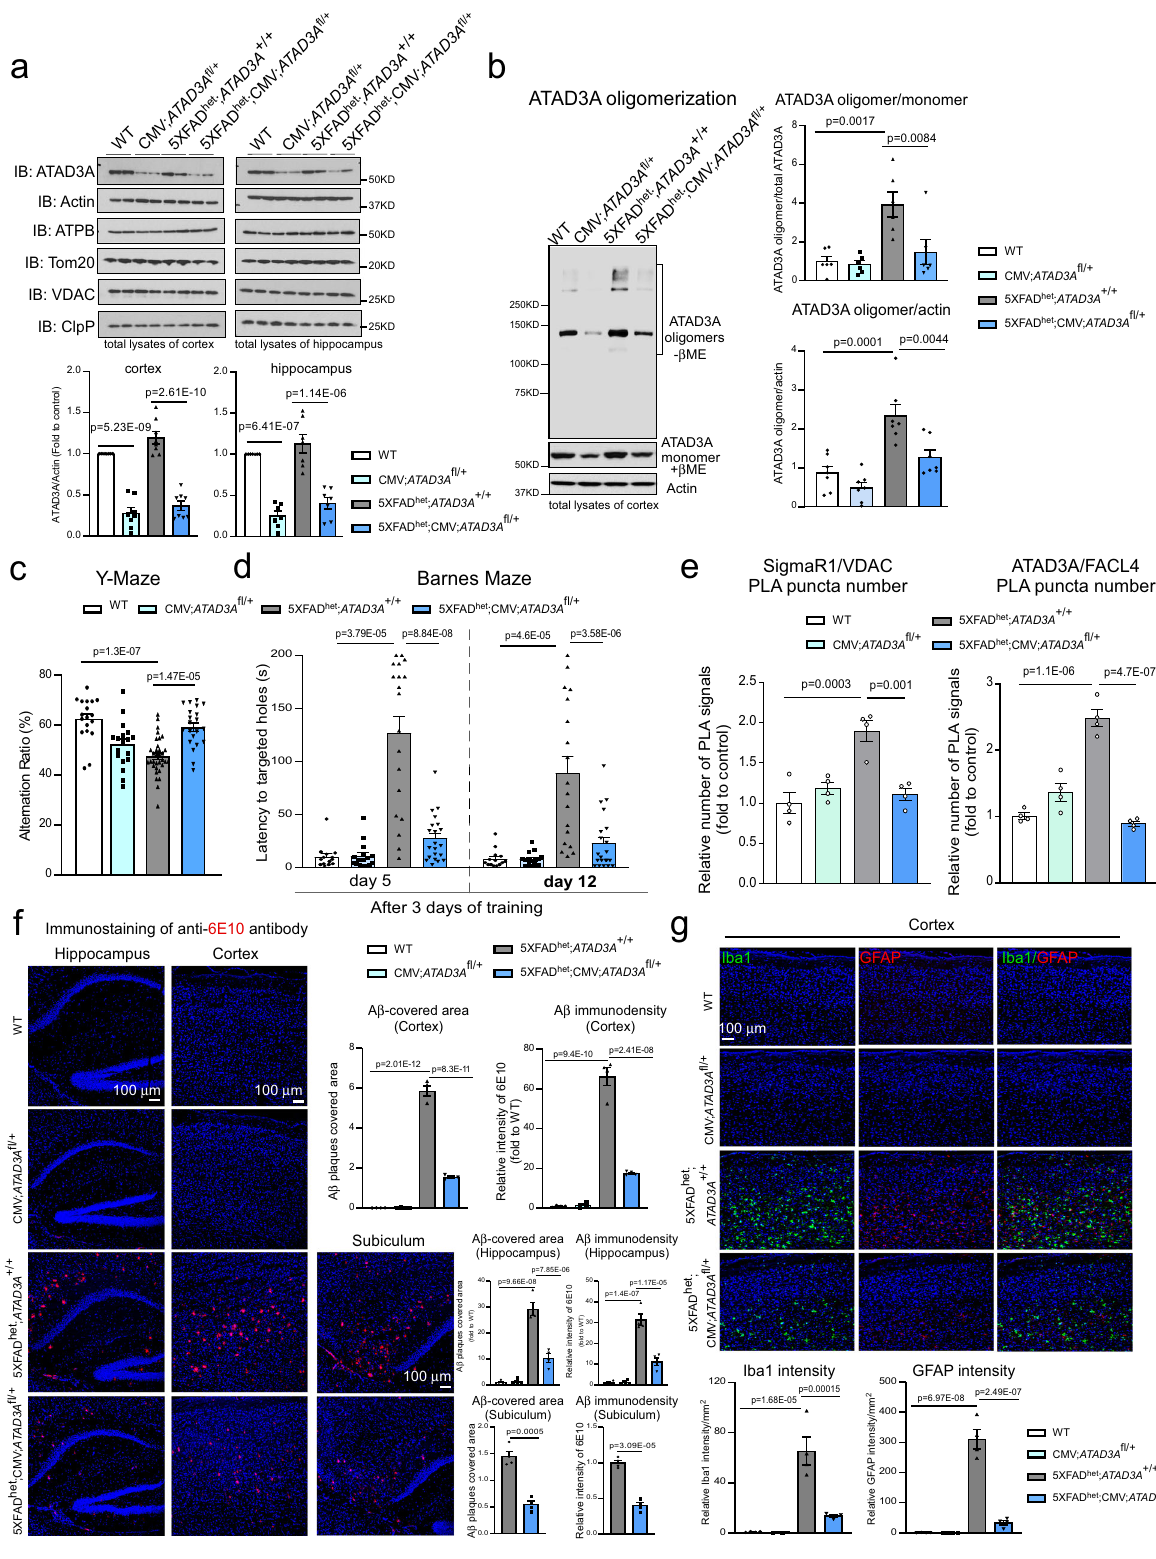
subcutaneously can enter mouse brains. In cultured HT-22 cells exposed to oligomeric A β 1 – 42 peptides, the DA1 peptide abolished ATAD3A oligomerization and elevated immunodensity signals (Supplementary Fig. 6a), validating the target. To test the in vivo ef fi cacy of the DA1 peptide, we subcutaneously treated homo- zygous 5XFAD (5XFAD homo ) mice with DA1 or control